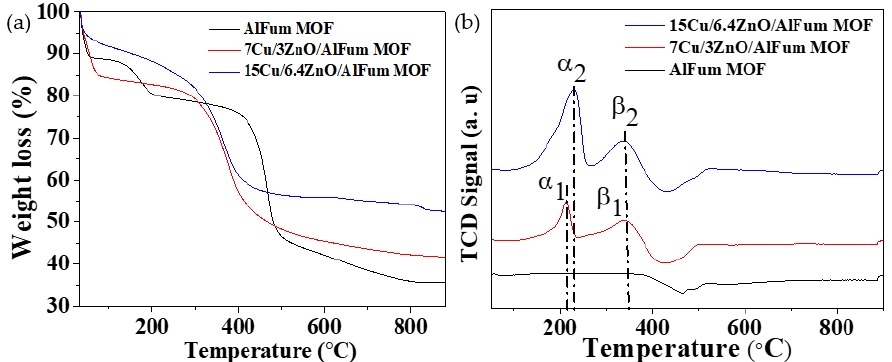
Figure 4. ( a ) TGA profiles of AlFum MOF, 7Cu/3ZnO/AlFum MOF, 15Cu/ZnO/6.4AlFum MOF; ( b ) H 2 -TPR profiles of: AlFum MOF, 7Cu/3ZnO/AlFum MOF, 15Cu/6.4ZnO/AlFum MOF. ( b ) H 2 -TPR profiles of: AlFum MOF, 7Cu/3ZnO/AlFum MOF, 15Cu/6.4ZnO/AlFum